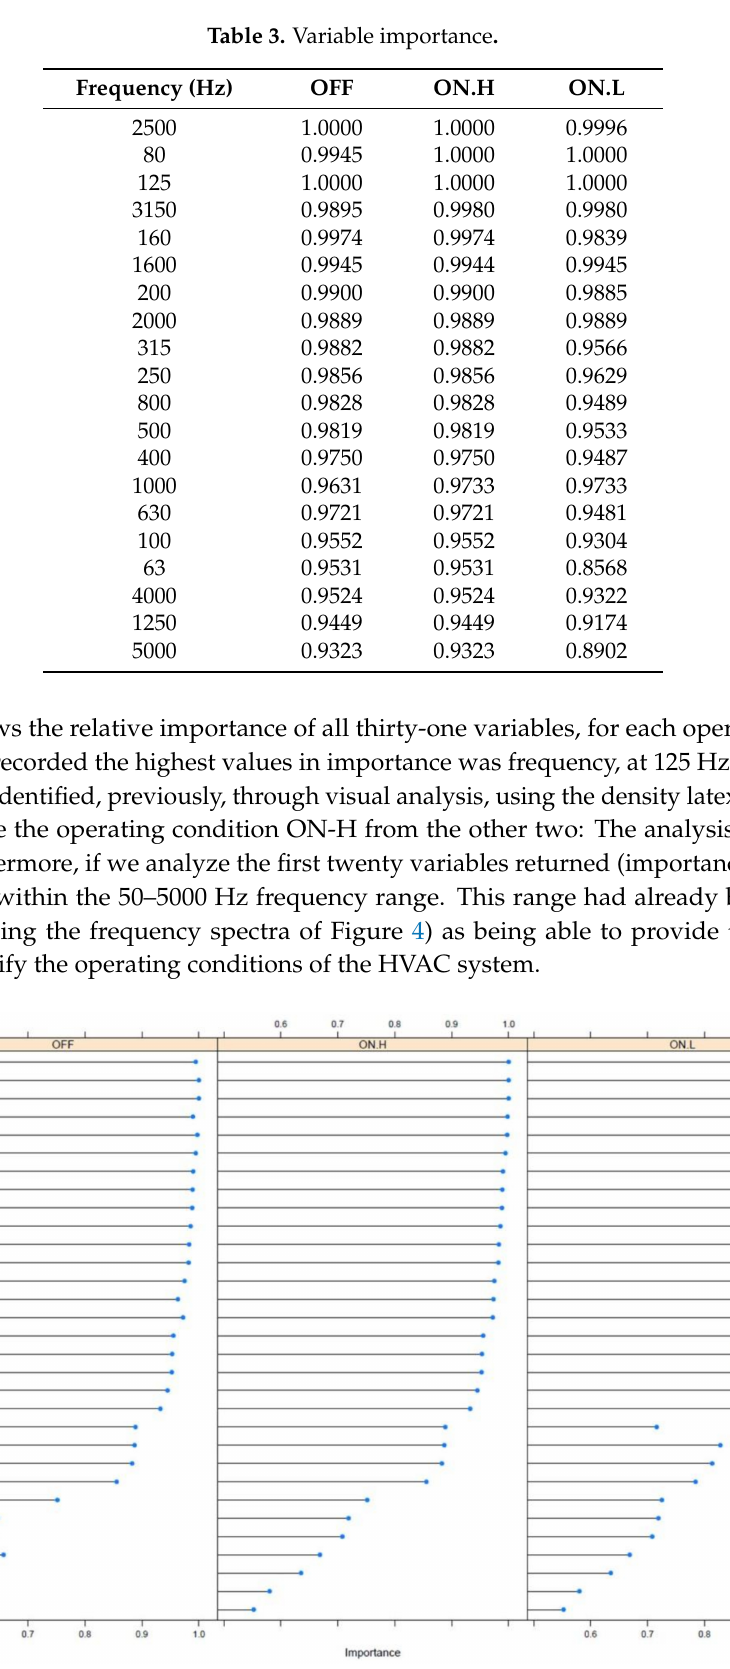
Figure 7. Relative importance of the variables for each operating